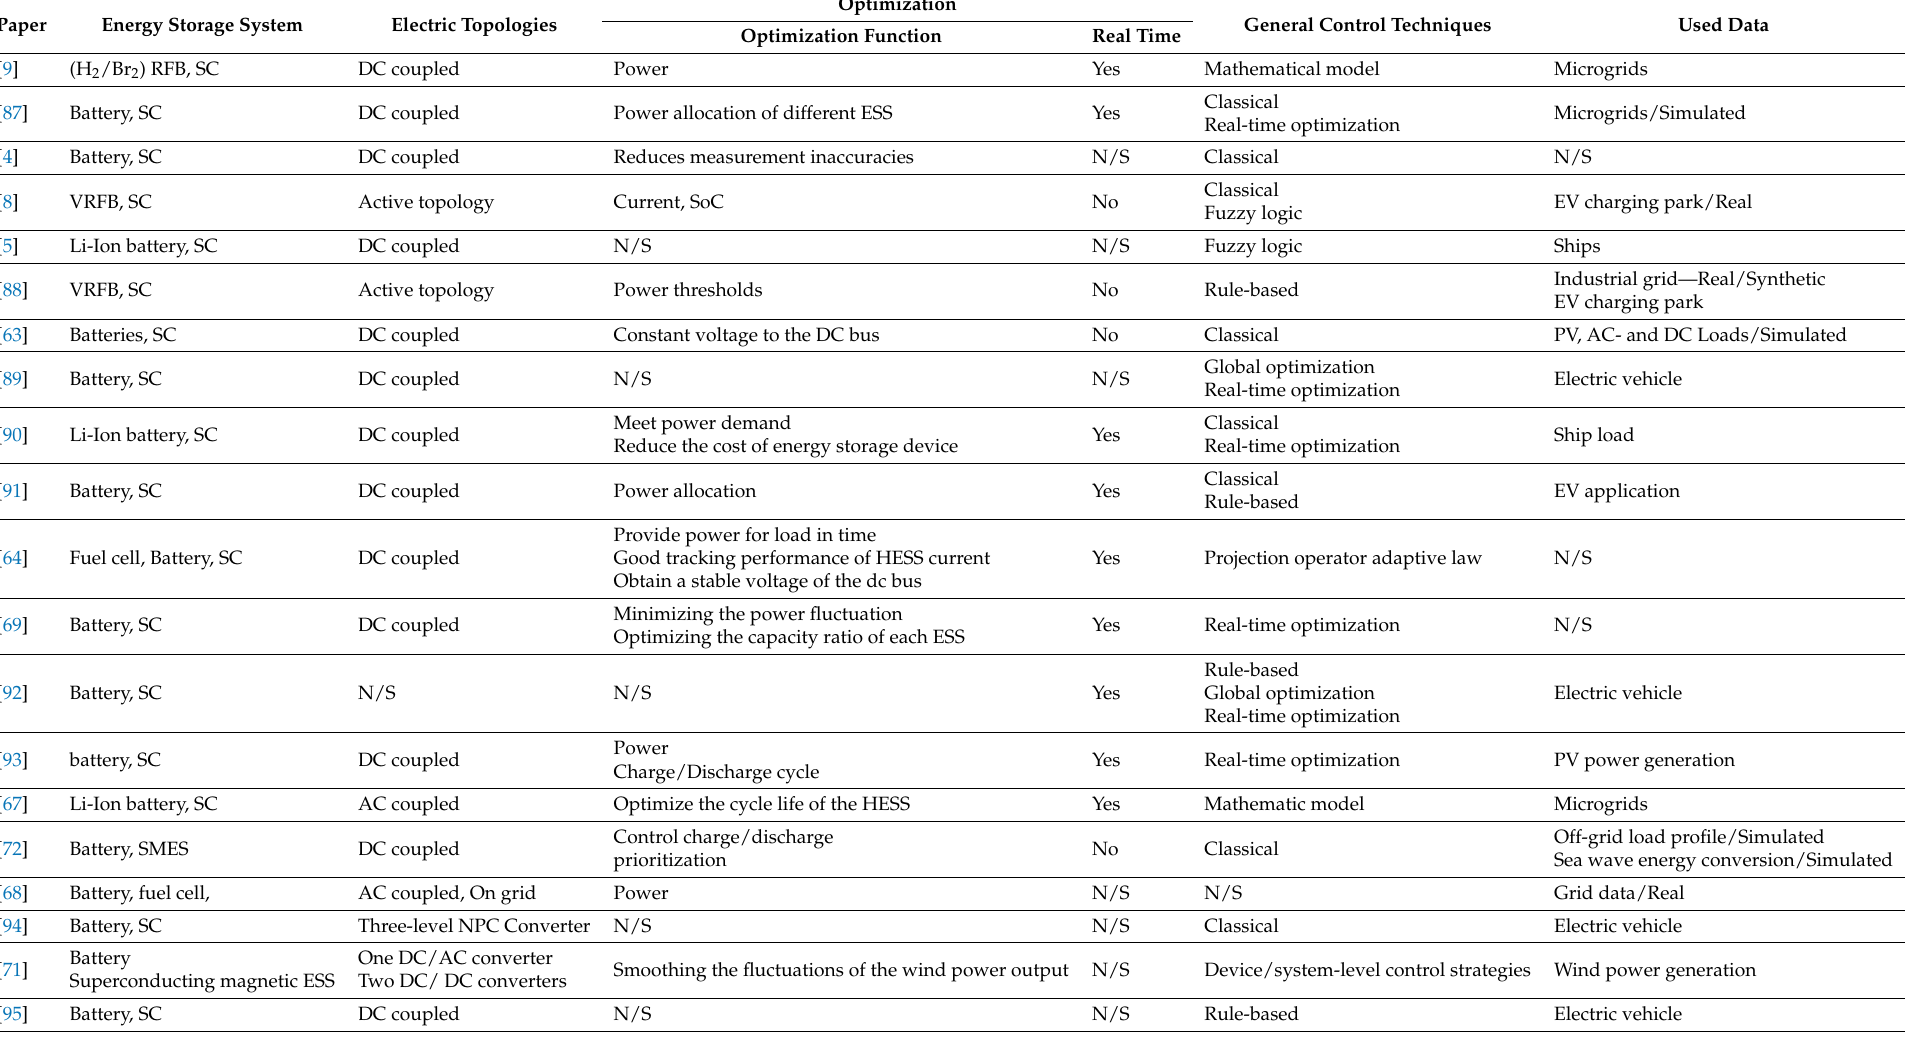
Table 7. Classification of HESS